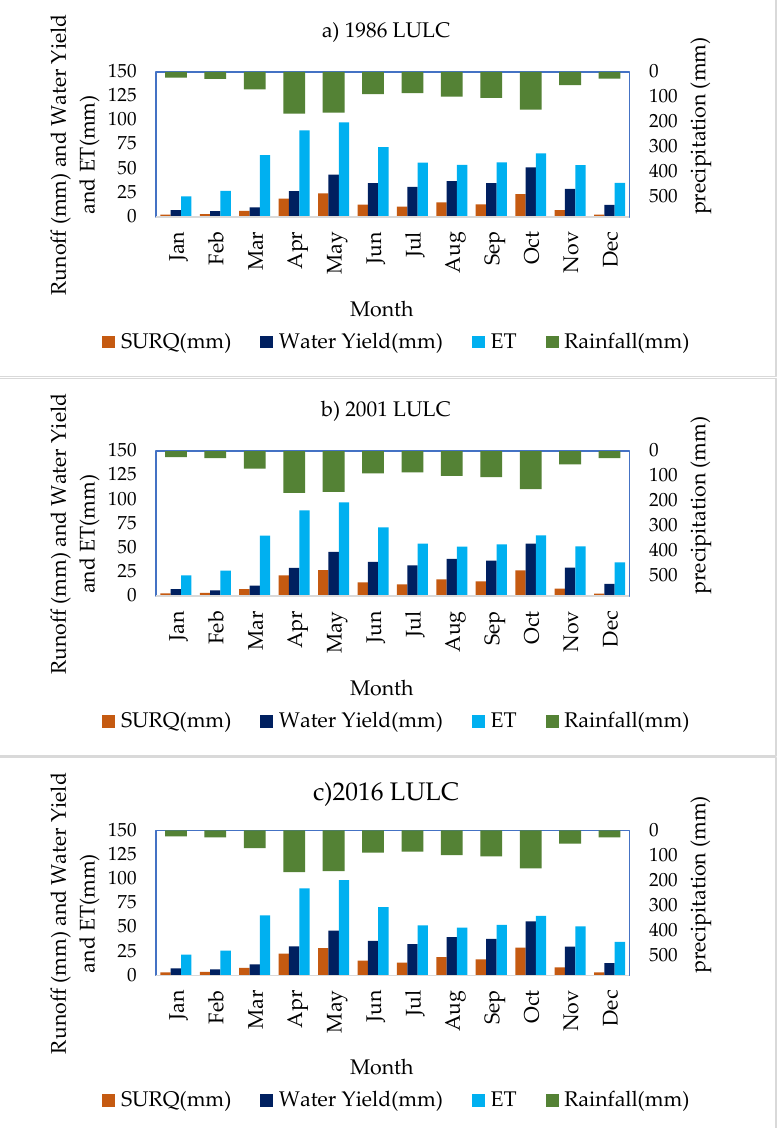
Figure 8. Monthly distributions of simulated precipitation, runoff, evapotranspiration, and water yield of LULC for ( a ) 1986, ( b ) 2001, and ( c ) 2016. The annual evapotranspiration in the subbasin varied from 581.06 mm to 968.37 mm, 563.61 mm to 895 mm, and 582.21 mm to 856.14 mm in the 1986 LULC, 2001 LULC, and